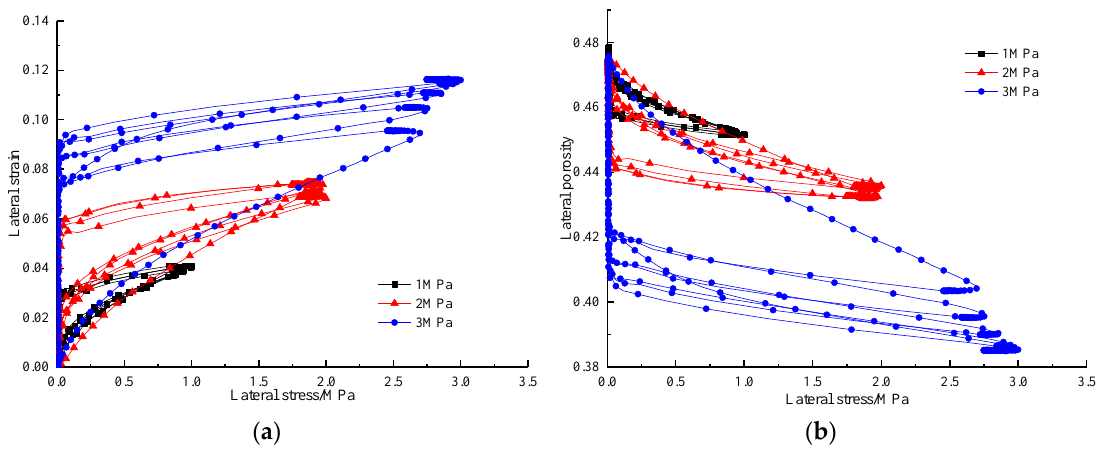
Figure 8. Changes in lateral strain and porosity of samples under lateral load. ( a ) Lateral strain; ( b ) Lateral porosity.